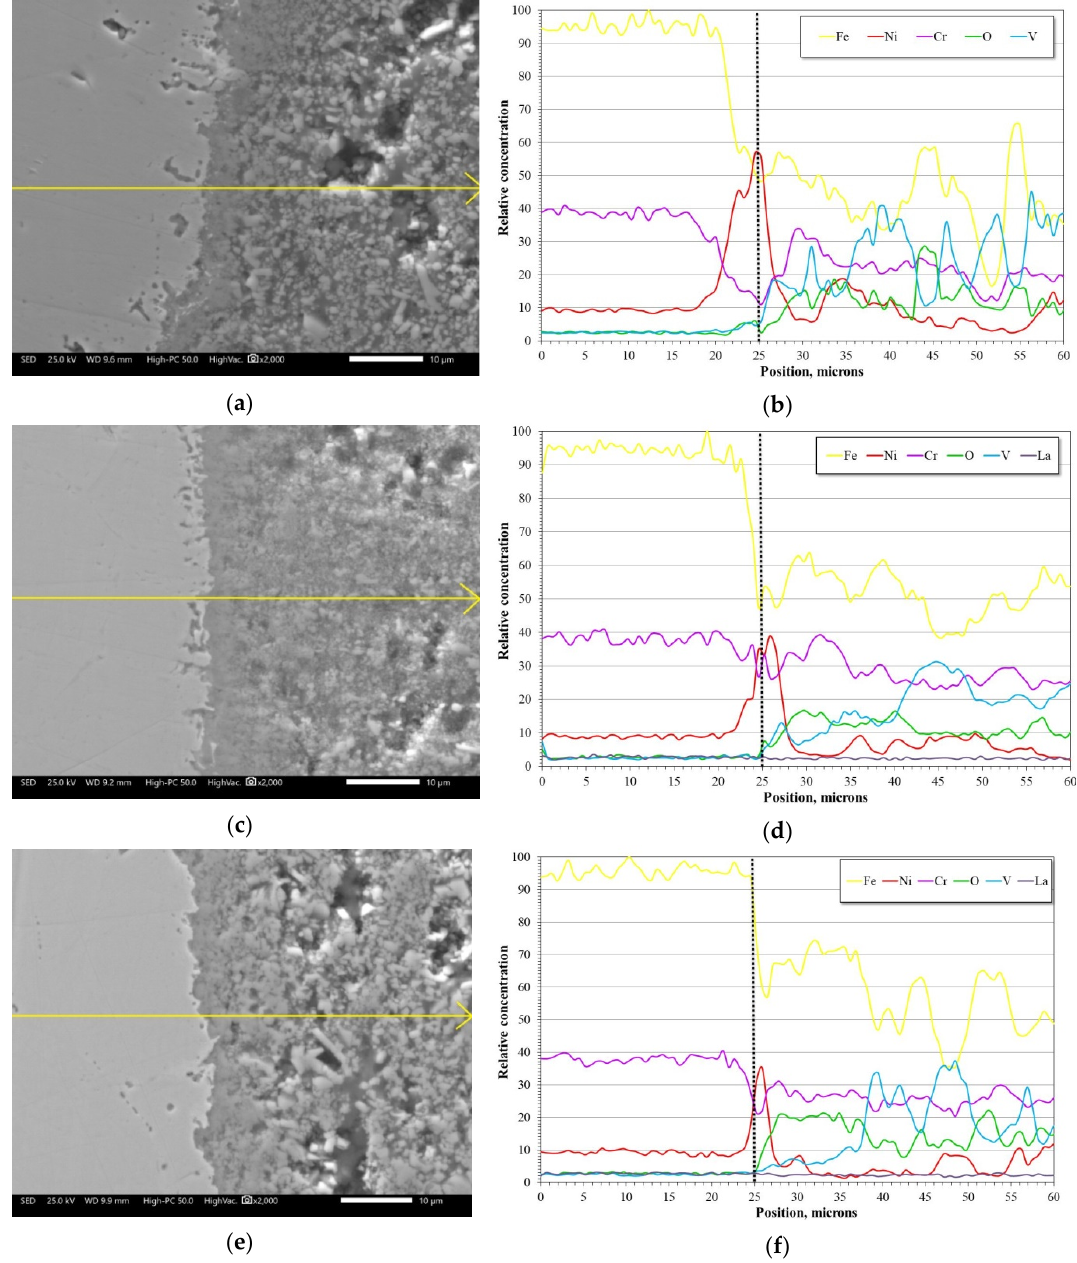
Figure 9. Line-scan of the relative concentration of elements for the 304H steel corroded at 900 °C for 100 h in: ( a , b ) NaVO 3 , ( c , d ) NaVO 3 -10%La(Ac) 3 , ( e , f ) NaVO 3 -10%La 2 O 3 . The dotted vertical line indicates the metal/corrosion products interface.